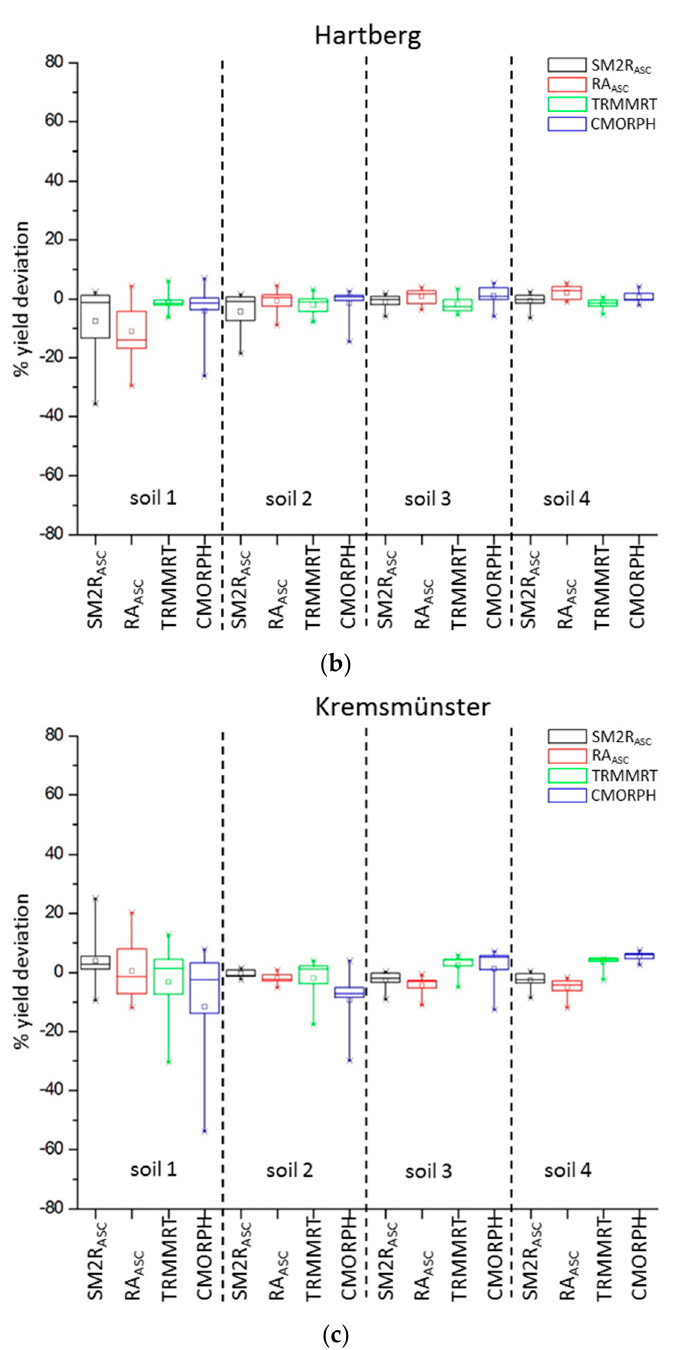
Figure 5. Boxplots of the relative differences [%] of spring barley yield INCA 23km vs. SM2R ASC (black line), RA ASC (red line), TRMMRT (green line) and CMORPH (blue line) precipitation inputs in ( a ) Groß-Enzersdorf; ( b ) Hartberg and ( c ) Kremsmünster 2007–2015. The box lines represent the 25th, 50th and 75th percentiles, while the whiskers present the max and min values.